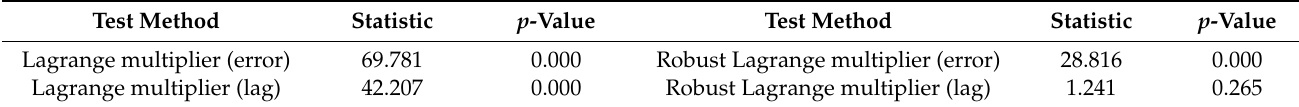
Table 3. Results of Lagrange multiplier (LM) test.